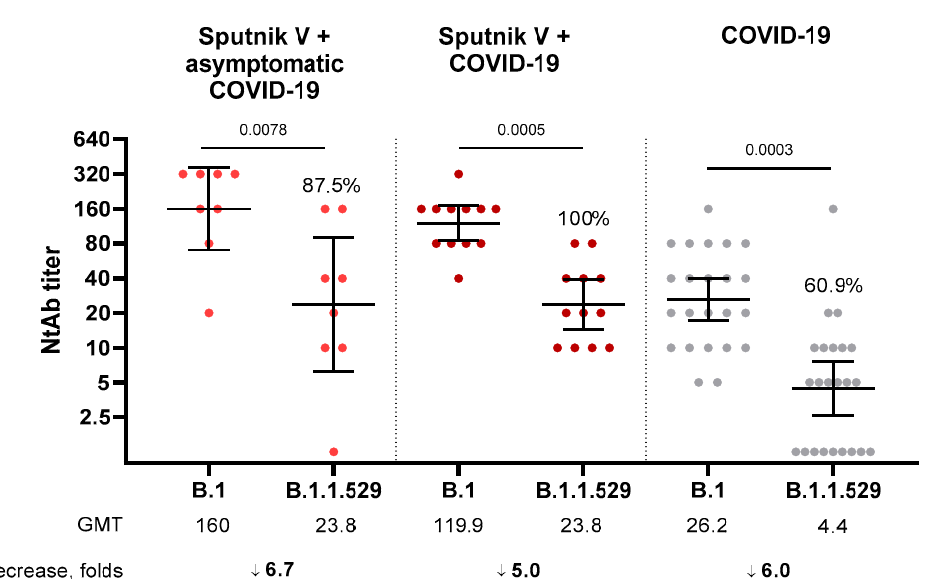
Figure 2. Titers of neutralizing antibodies in samples of individuals vaccinated with Sputnik V; vaccinated with Sputnik V after/before asymptomatic COVID-19; vaccinated with Sputnik V after/before mild COVID-19 and COVID-19 convalescents. The figure shows individual data for the studied samples, geometric mean and 95% CI. The figure shows the p -value (Wilcoxon test), % of individuals with detectable NtAb to the SARS-CoV-2, geometric mean and the level of NtAb decrease. Grey box—limit of detection. Values below the limit of detection were assigned a value of NtAb